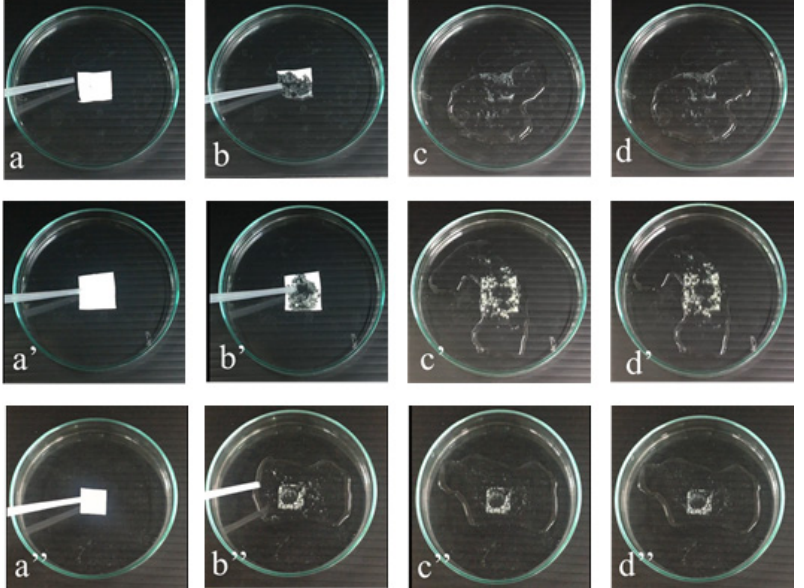
Figure 8. The digital photographs of solubility behavior of pullulan nanofibers (12P), JFP/pullulan